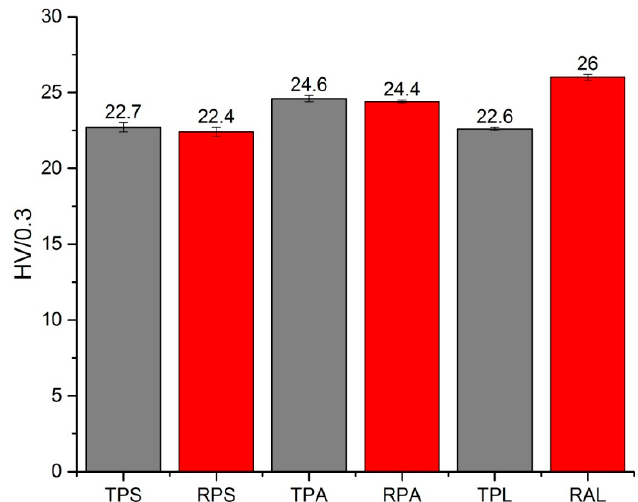
Figure 5. Average Vickers hardness values obtained for all PMMA samples before artificial aging and respective error bars.